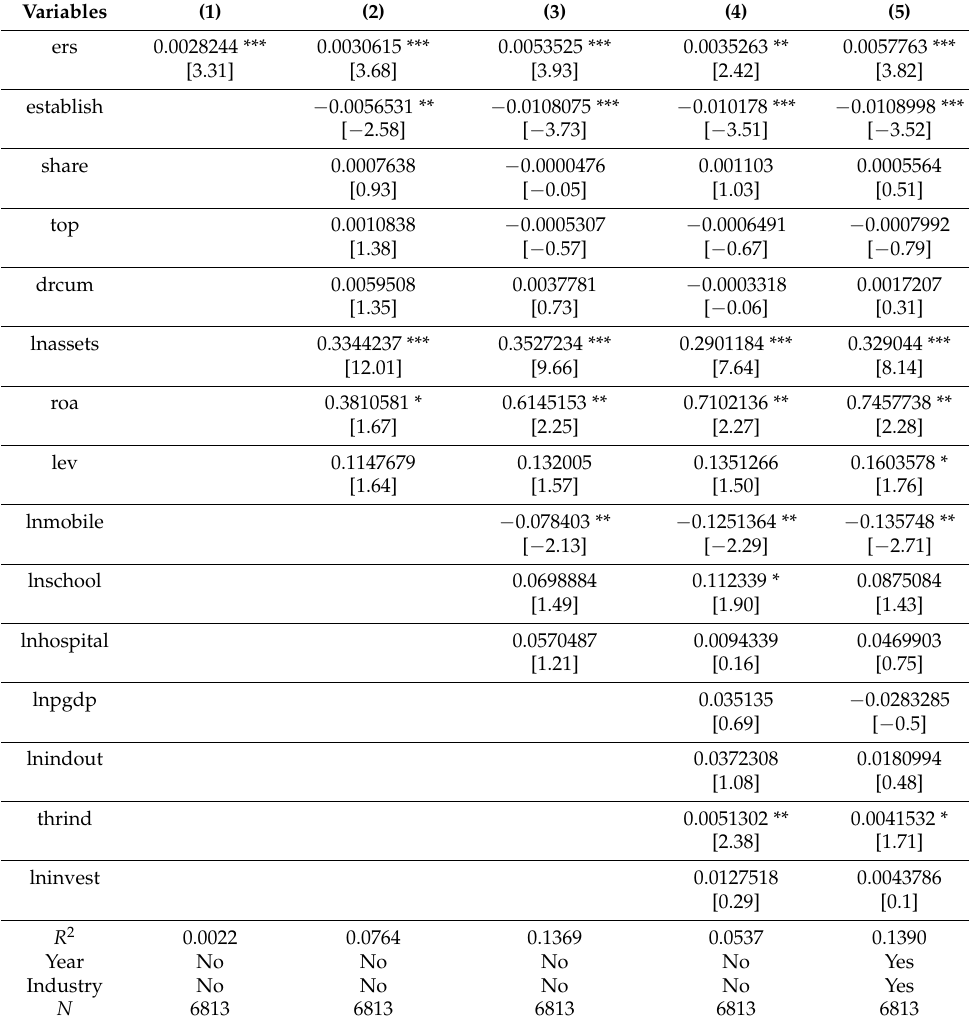
Table 5. Baseline results: environmental regulation and corporate green